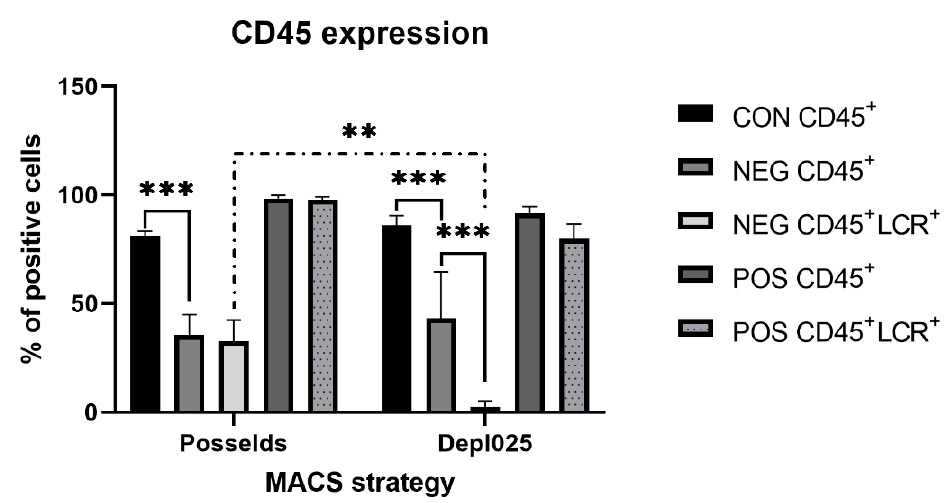
Figure 2. MACS sorting efficiency and purity of sorted cells. The numbers of single positive (CD45 + ) and double positive (CD45 + LCR + ) cells were compared among the control (unsorted) samples and both sorted fractions. CON—control sample, NEG—negative fraction, POS—positive fraction. The data from eight experiments are expressed as the mean ± SD; **—difference is statistically significant at p < 0.01; ***—difference is statistically significant at p < 0.001.